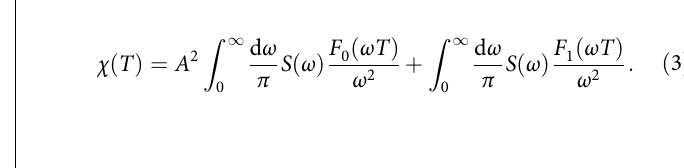
B μ T Hz − 1/2 . Similarly, the sensitivity can max at a sensitivity of ~2 be improved without changing B max by decreasing the interaction time, with a limit set by the adiabaticity condition ( A (cid:2) _ ρ sin θ = 2 R (cid:5) N = Ω T (cid:3) 1).